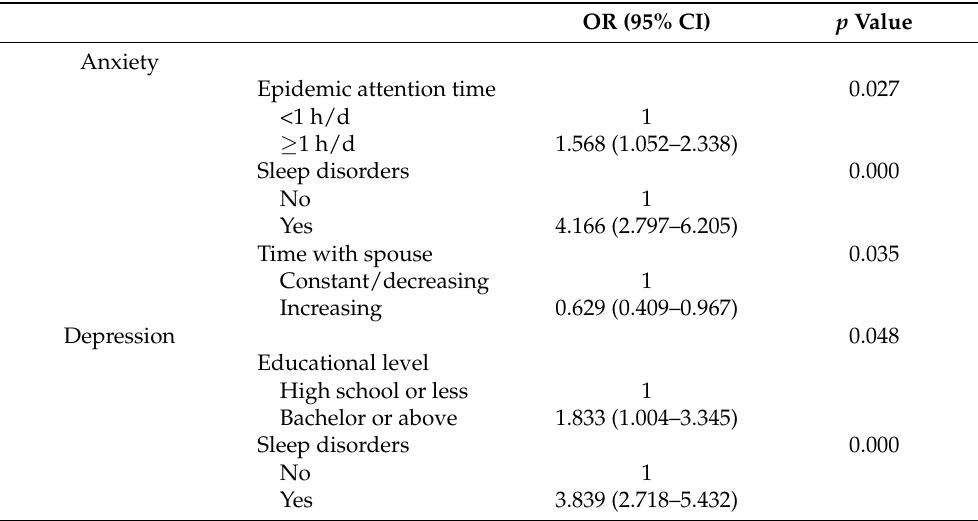
Table 3. Logistic regression analysis of risk factors for anxiety and depression in pregnant women during COVID-19. OR (95% CI) p Value Anxiety Epidemic attention time 0.027 <1 h/d 1 ≥ 1 h/d 1.568 (1.052–2.338) Sleep disorders 0.000 No 1